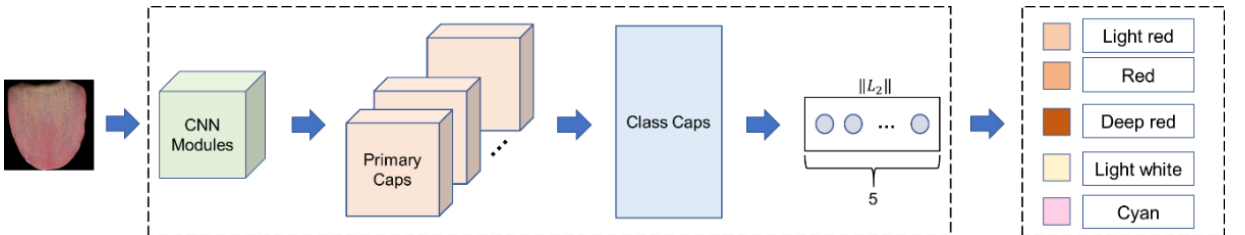
Figure 11. The framework of CNN + Caps.